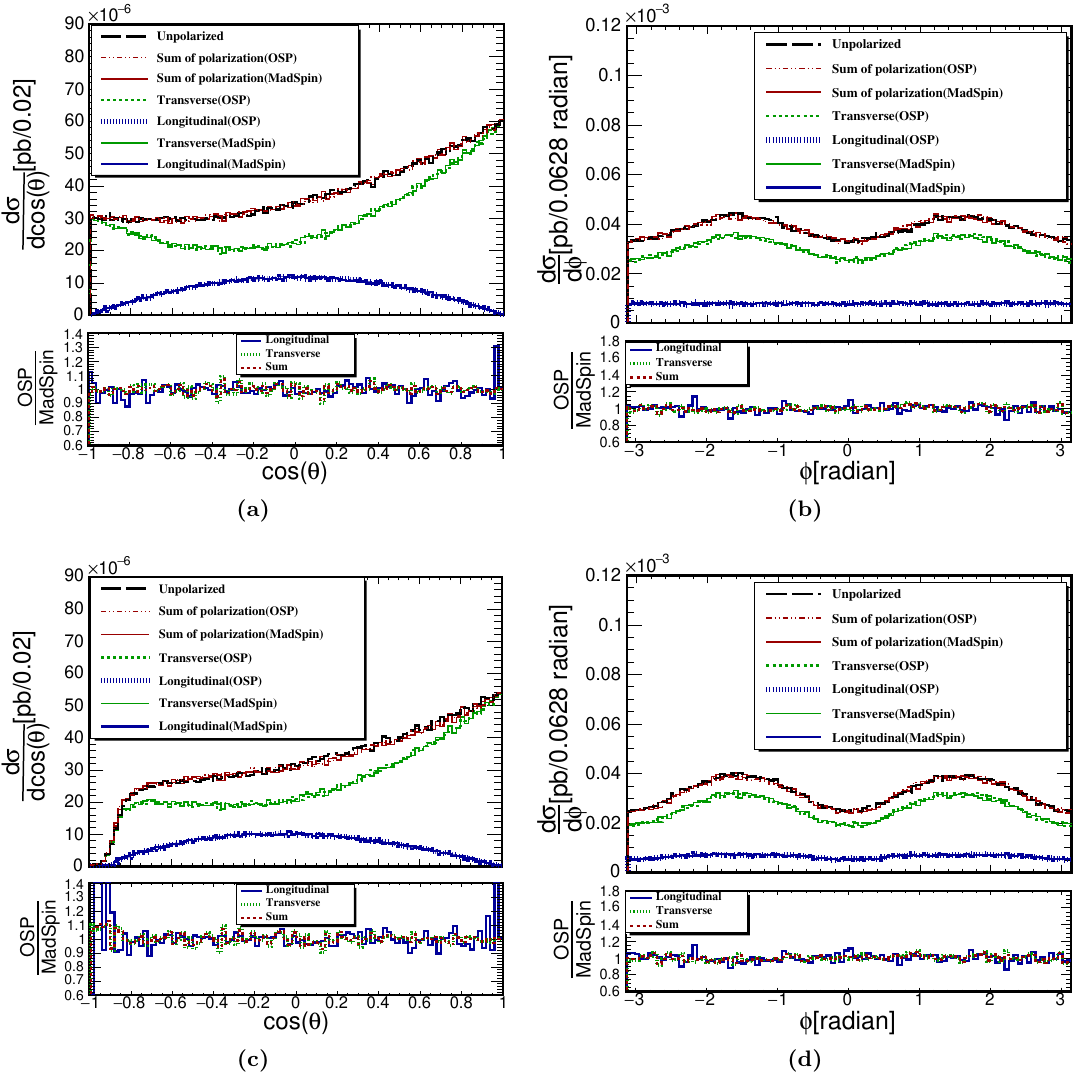
Figure 2. Upper Panels: for (a,c) cos (cid:18) and (b,d) (cid:30) , overlapping distributions of unpolarized jjW + W (cid:0) production (black; dash-double dot), transversely polarized W (cid:0) production (green), (cid:21) longitudinally polarized W (cid:0) production (blue), and polarization-summed W (cid:0) production (red), (cid:21) (cid:21) with W + W (cid:0) decays treated using the MadSpin (solid) and OSP (bar) methods, assuming (a,b) only generator-level cuts of eq. (4.15) and (c,d) both eq. (4.15) and analysis-level cuts of eq. (4.23). Lower Panels: the OSP-to-MadSpin ratio of the polarized and polarization-summed distributions.